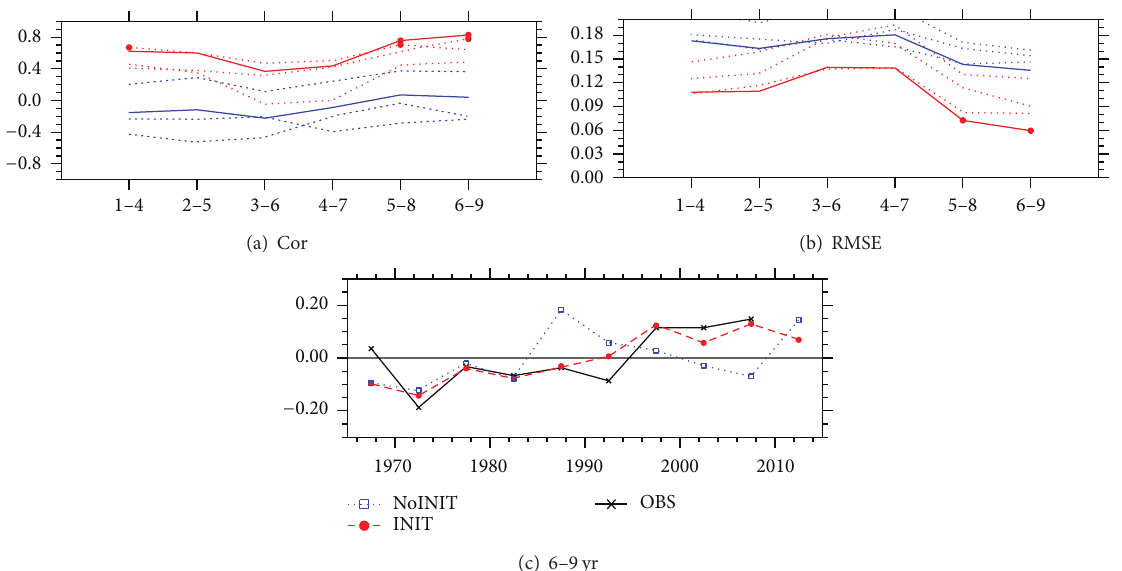
Figure 5: As in Figures 3(a)–3(c), but for the Atlantic multidecadal variability index.